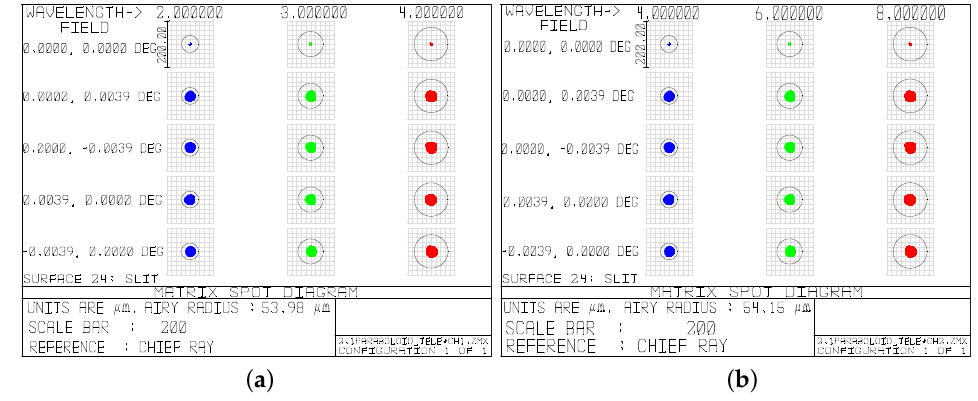
Figure 8. Matrix spot diagrams at exit of dichroic system (slit surface) for ( a ) CH1 and ( b ) CH2. Different boxes show image spots and Airy spots at different FOVs and wavelengths. ( a ) Spot diagram of CH1. Boxes in different rows correspond to different FOVs. Second, third, and fourth columns show imaging results at the exit of dichroic system at wavelengths of 2, 3, and 4 µ m, respectively.